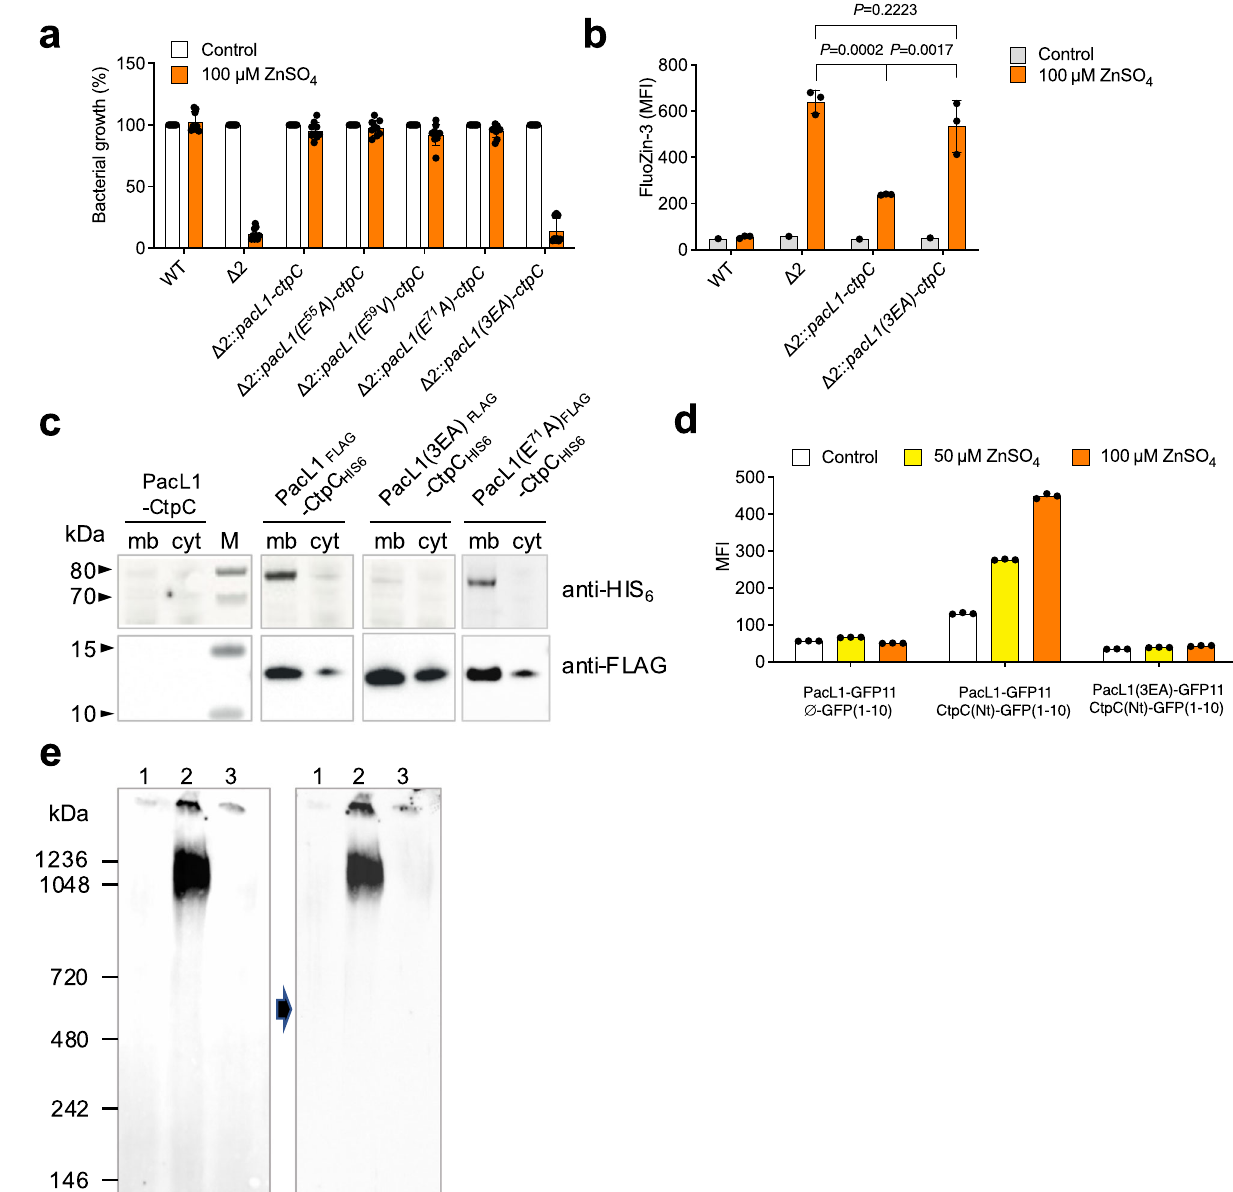
Fig.6 |PacL1Glu/Alarepeatsarerequiredforabundant CtpClevels,resistance to zinc intoxicationand formationof high molecular weight complexes in the mycobacterial membrane. a M. smegmatis wild-type strain (WT), Δ 2 mutant, or Δ 2expressing recombinant CtpC and nativePacL1orPacL1E 55 A,E 59 V,E 71 Aor3EA variants were cultivated for 24h in complete 7H9 medium in the absence (Control, white bars) or presence (orange bars) of 100 μ M ZnSO 4 . Bacterial growth was quanti fi ed by turbidity measurement (expressed as % of untreated control). Data show mean±s.d of a biological replicate ( n =3), and are repre- sentative of 2 independent experiments. b The indicated M. smegmatis strains were cultivated in complete 7H9 without ADC supplemented with 100 µ M ZnSO 4 , incubated with FluoZin-3 at 1mM for 1h, and washed twice in PBS. Bac- terial fl uorescence was measured by fl ow cytometry and expressed as mean fl uorescence intensity (MFI). Data show mean±s.d of a biological replicate ( n =3), and are representative of 2 independent experiments. Data were ana- lyzed using one-way ANOVA. c Western-blotting analysis of cytosolic (cyt) and membrane (mb) fractions from M. smegmatis Δ 2 expressing recombinant PacL1 and CtpC, or HIS 6 -tagged CtpC and FLAG-tagged PacL1, or the PacL1 E 71 A or 3EA variants. The upper membrane was treated for HIS 6 immuno-detection and the